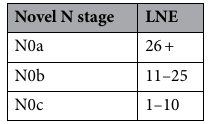
Table 2. Grouping of nN stage.